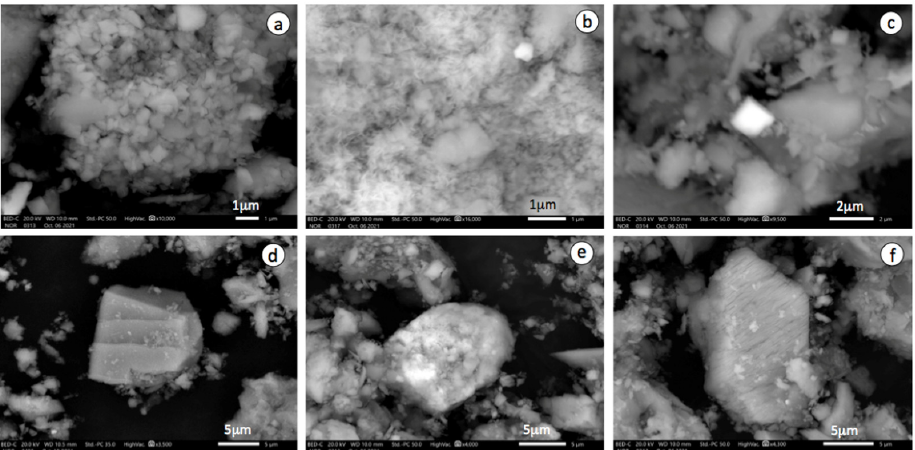
Figure 3. ESEM-BSE images showing salient mineralogical and textural features of the amended soil after 12 years of amendment application: ( a ) aggregate of jarosite with pseudocubic habit of euhedral crystals; ( b ) iron oxide nanoparticle aggregate; ( c ) isolated pseudocubic crystal of plumbojarosite; ( d ) calcite grain with dissolution grooves on its surface; ( e ) iron oxide coating calcite grain; and ( f ) newly-formed crystal of gypsum.